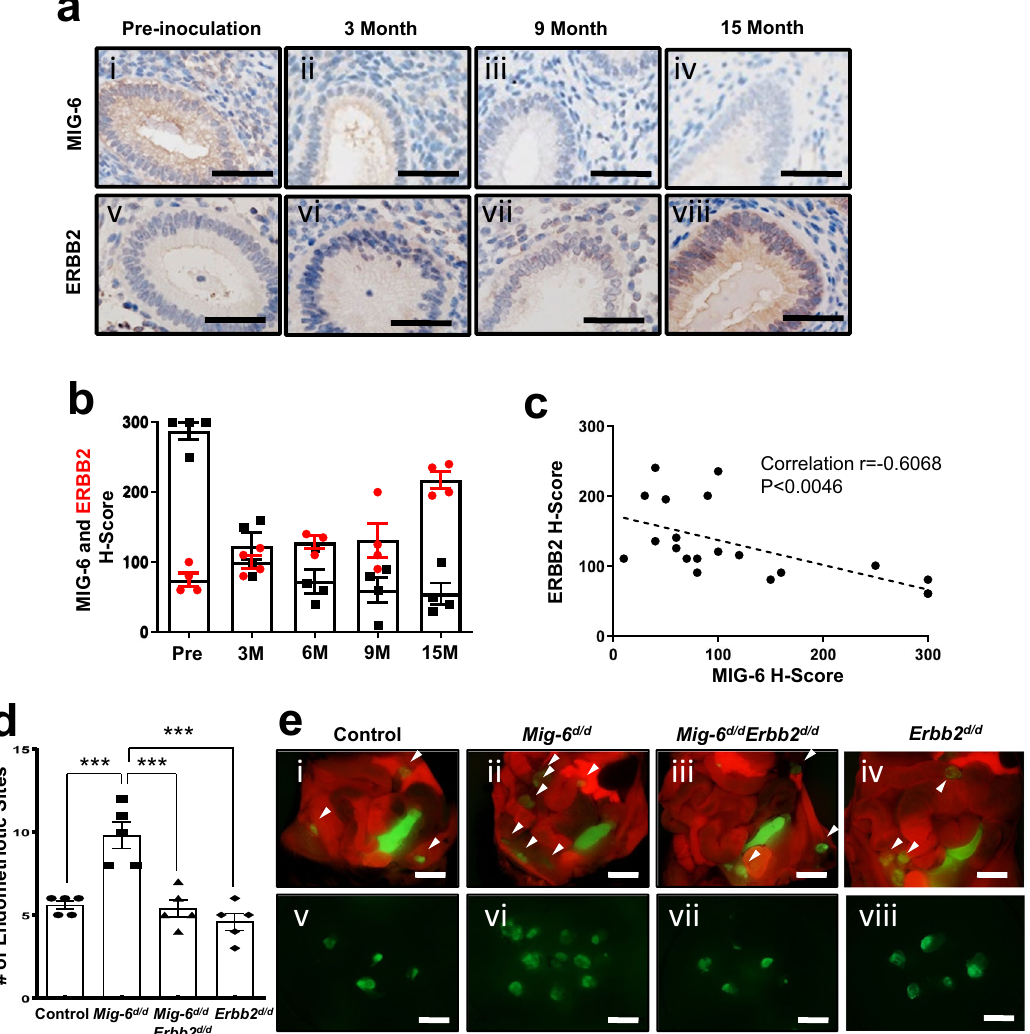
Fig. 6 The reverse correlations between MIG-6 and ERBB2 proteins in the endometriosis baboon model. a – c Immunohistochemical representative photomicrographs ( a ) and H-score ( b ) of MIG-6 (black) and ERBB2 (red) in the endometriosis baboon model induced by intraperitoneal inoculation of menstrual endometrium during progression of endometriosis in pre-inoculation, 3, 6, 9, and 15 months ( n = 4 per period). Scale bars: 50 μ m. c The reverse correlations between MIG-6 and ERBB2 proteins (Spearman correlation coef fi cient r = − 0.6068, The two-tailed p value is 0.0046). d , e Average total number ( d ) and representative fl uorescence photomicrographs ( e ) of endometriotic sites in control, Mig-6 d/d , Mig-6 d/d Erbb2 d/d , and Erbb2 d/d mice by induced endometriosis based on mT/mG mice ( n = 5 per genotype). Endometriotic lesions were visualized by GFP expression in the outside of uterus. White arrow indicates endometriotic lesions. Data are represented as mean ± SEM, *** p = 0.0003, *** p = 0.0002, and *** p < 0.0001 by Ordinary one- way ANOVA test. Scale bars: 1 cm. Three independent experiments were performed for a - e with similar results. Source data are provided in the Source Data fi